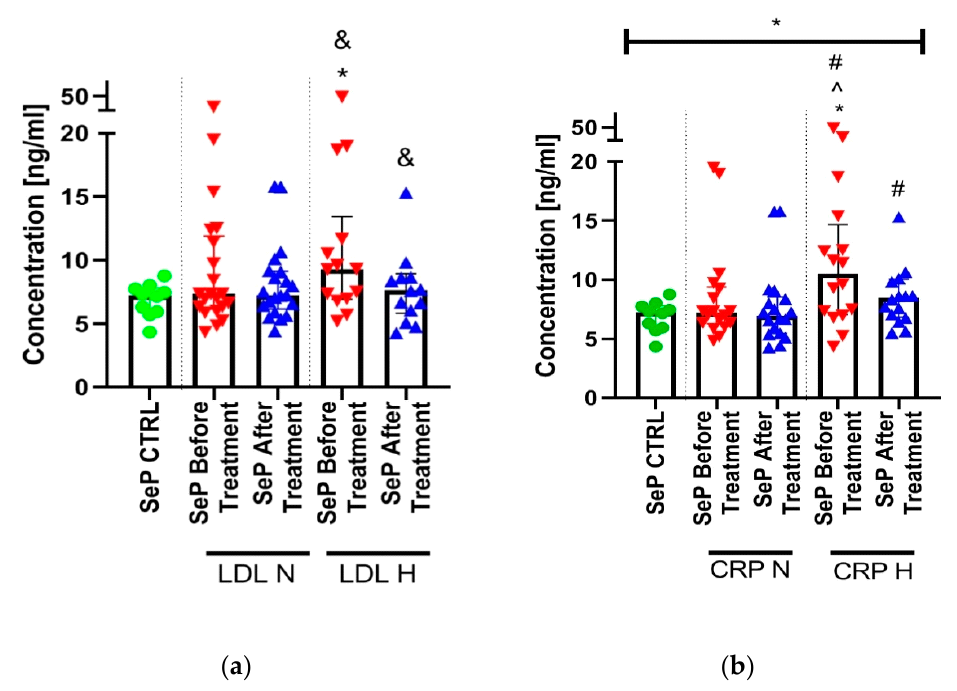
Figure 3. The levels of SeP in LDL normal and elevated subgroups ( a ) or in hs-CRP normal and elevated subgroups ( b ) before and after treatment. (LDL N: n = 19; LDL H: n = 4; CRP N: n = 7; CRP H: n = 16). * means p lower than 0.05 when comparing any single subgroup to the controls. ^ shows p < 0.05 when compared both subgroups before treatment. & and # mean the existence of statistical significance at level lower than 0.05 when analyzing SeP CTRL and both subgroups in LDL H/CRP H using ANOVA. The asterisk above the graph (b) shows the p < 0.05 when comparing all included subgroups using ANOVA.